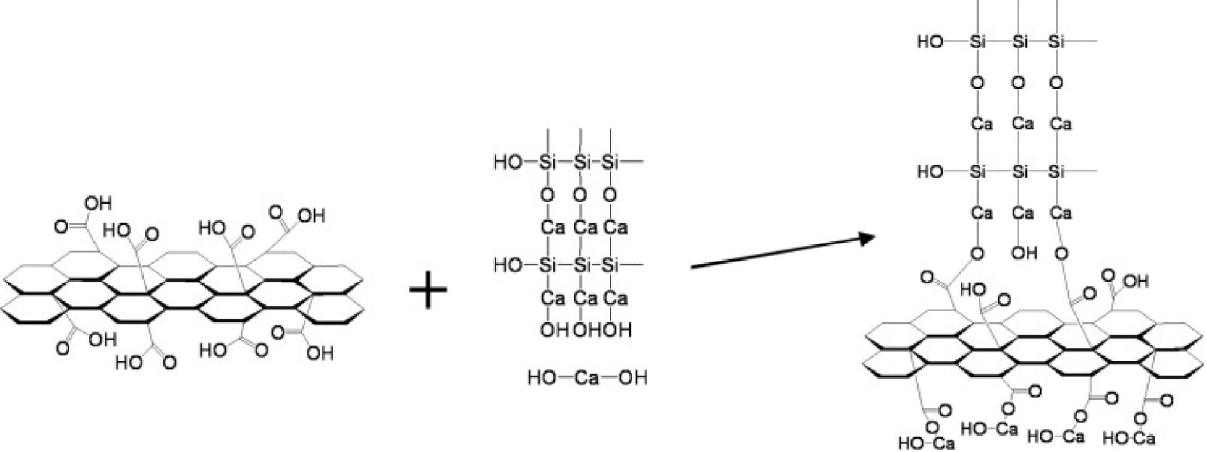
Figure 12: Schematic reaction between carboxylic acid groups and Ca(OH) 2 , C–S–H in cement [113]